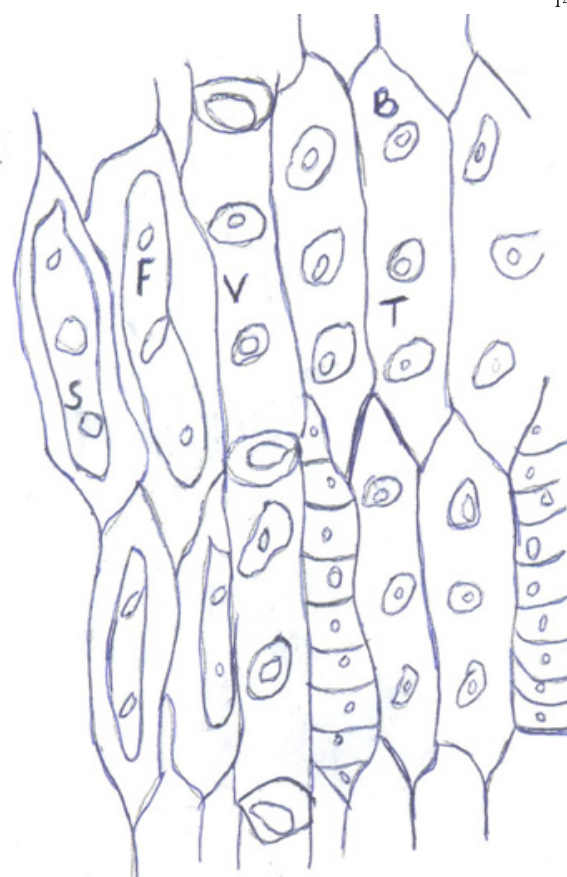
Fig. 2. Tangential Longitudinal Section (TLS) of Vitellaria par- adoxa wood ×40 F = Fibre; V = Vessel; T = Tracheid; B = Bordered pit; S = Simple pit